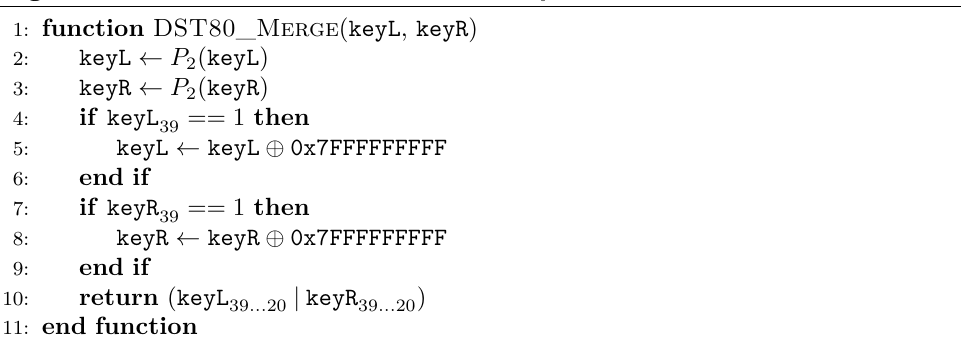
Algorithm 1 Generation of the DST80 round key